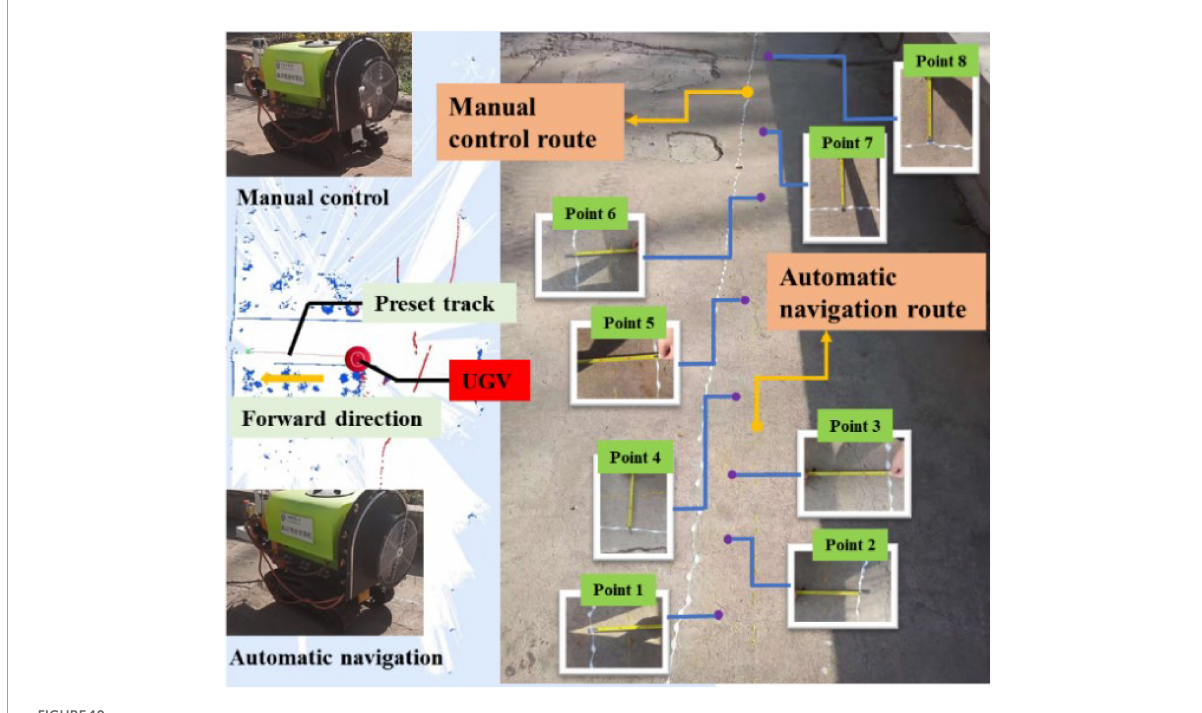
track tracking control. At this time, the paint bag hanging at the tail of the UGV was yellow paint, forming a yellow paint track line on the ground. The eight selected points were shown in Figure 19 , and the measurement results were shown in Table 4 . It can be concluded from Table 4 that the error of each point was within 15 cm in the eight selected points, and the average